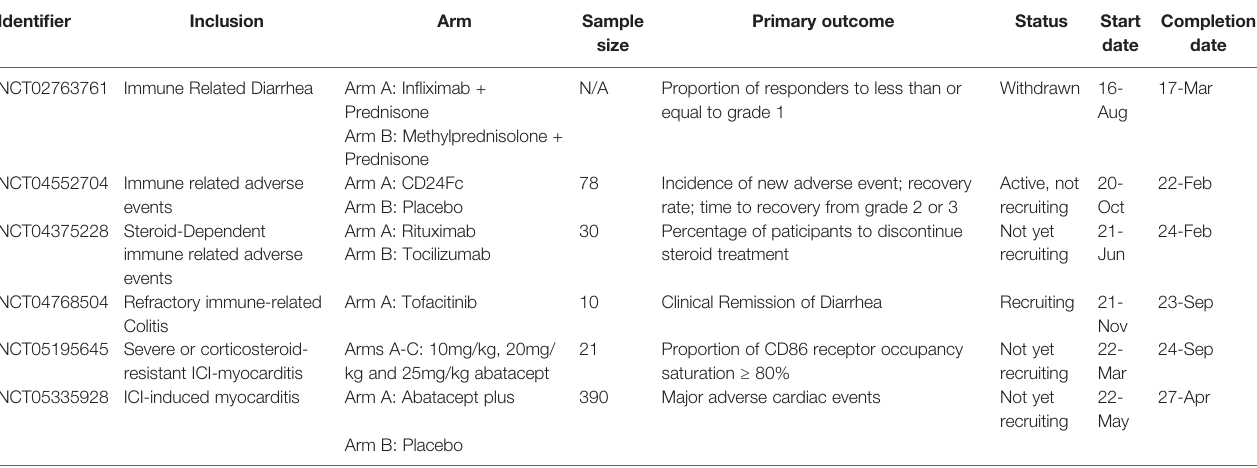
TABLE 4 | Ongoing registered clinical trials.